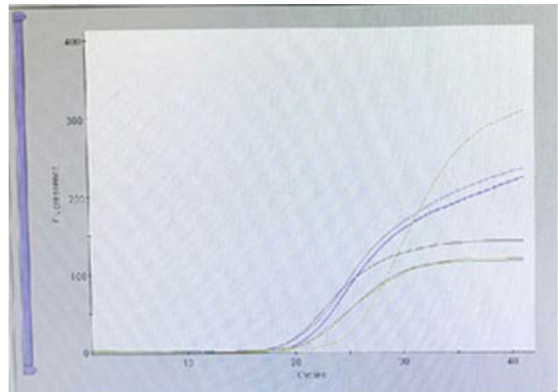
fIguRE 4 – Positive molecular rapid test for M.